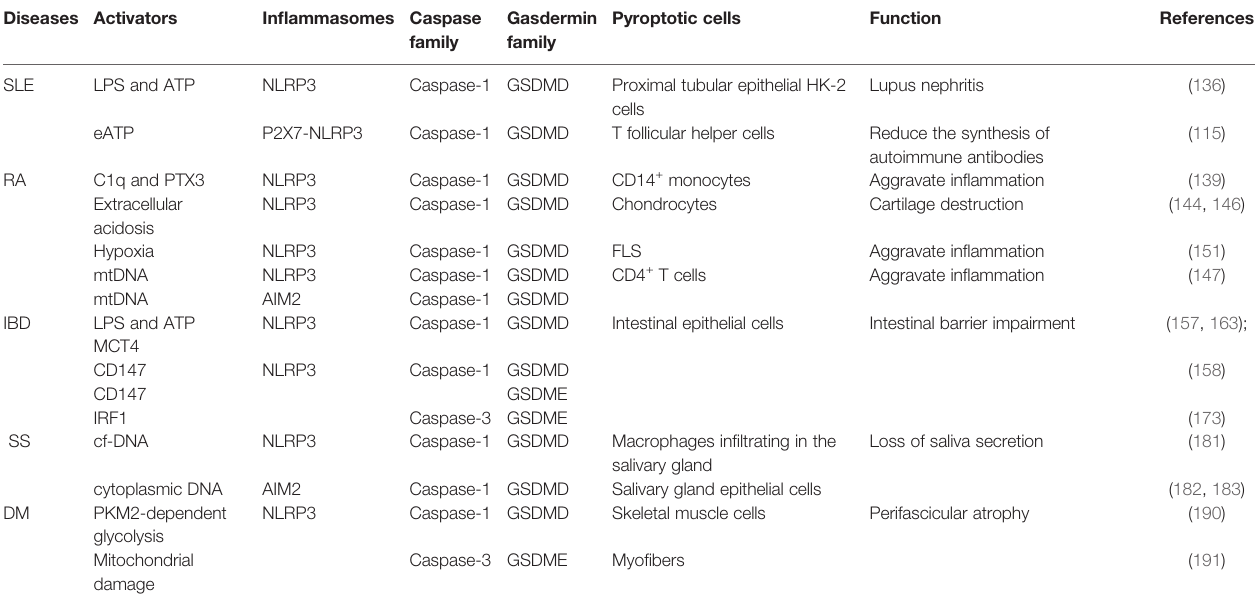
TABLE 1 | Summary of pathway and role of pyroptosis in autoimmune diseases. Diseases